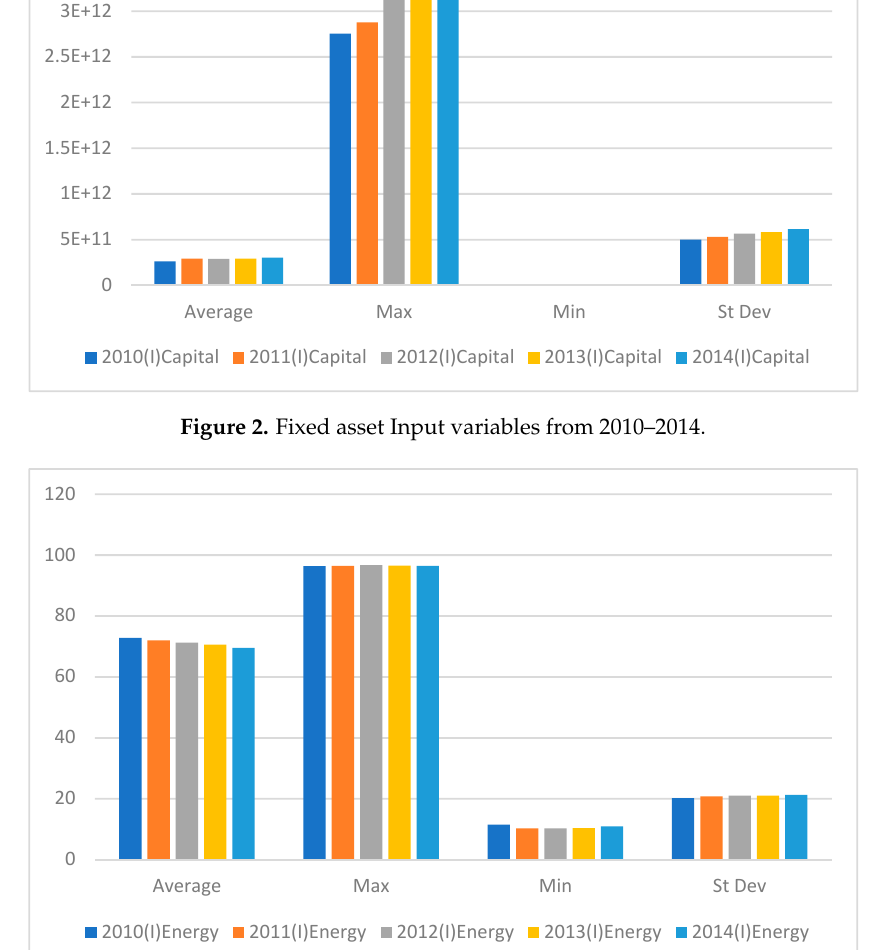
Figure 3: Energy Input variables from 2010-2014 Figure 3. Energy Input variables from